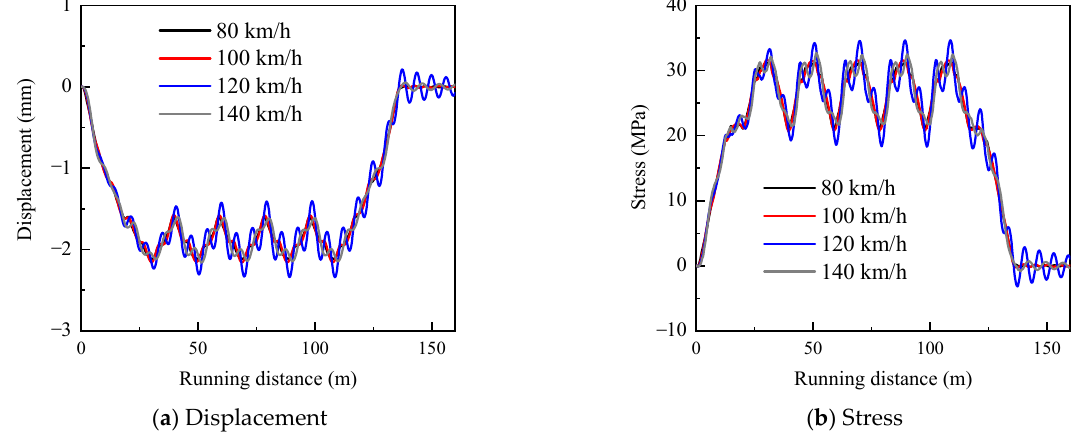
Figure 6. Time–history response curves of midspan of 25 m-span bridge.